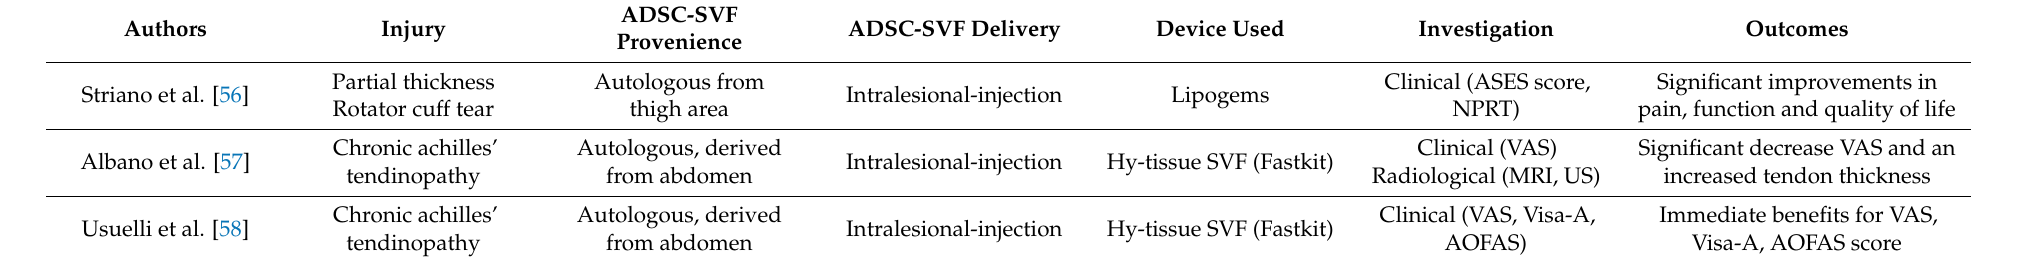
Table 3. Mechanically derived ADSC-SVF human tendinopathy and tendon